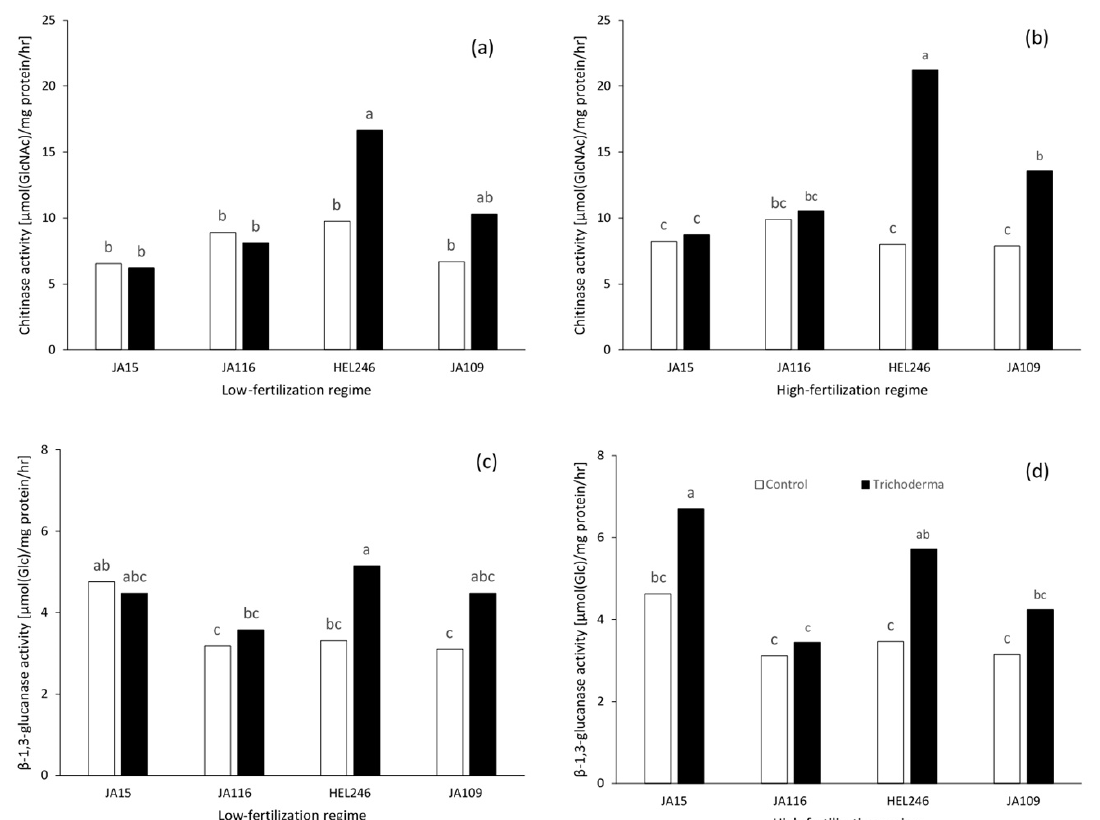
Figure 1. Enzyme activity of Trichoderma application and non- Trichoderma application for four Jerusalem artichoke genotypes at seven days after transferring seedling (DATS) under two fertilization regimes. ( a ) Chitinase activity at low fertilization regime; ( b ) Chitinase activity at high fertilization regime; ( c ) β -1,3-glucanase activity at low fertilization regime; ( d ) β -1,3-glucanase activity at high fertilization regime. Di ff erent letters indicate significant di ff erences at p ≤ 0.05 among treatments.